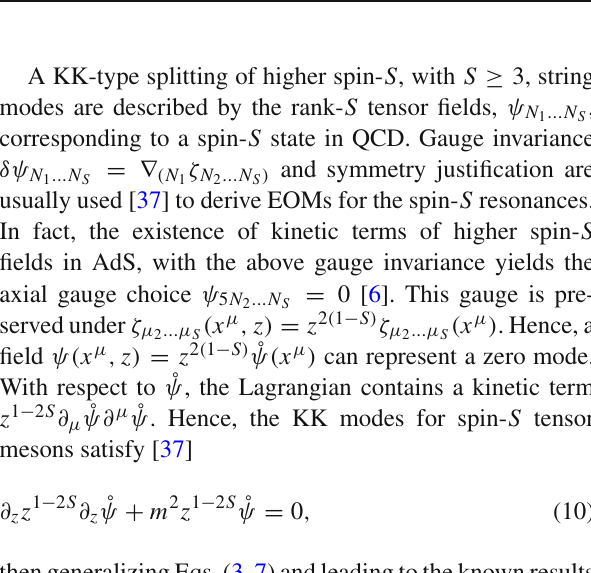
then generalizing Eqs. (3, 7) and leading to the known results for spin-1 and spin-2 modes. The normalizable solutions of Eq. (10) are of the form z S J S ( mz ) .WhenNeumannboundaryconditionsareimposed in the IR regime, Ref. [37] derives the mass of the lightest spin- S particle resonance as the first zero of the J S − 1 ( mz ) function. This leads to the tensor mesons spin- S resonances in QCD. The first column in Table 1 encompasses the spin, S , of the respective spin- S tensor meson resonances, whereas the second column depicts the ρ( 770 ) , f 2 ( 1270 ) , ω 3 ( 1670 ) , f 4 ( 2050 ) , ρ 5 ( 2350 ) , f 6 ( 2510 ) tensor mesons. The third and forth column indicate, respectively, the tensor mesons family mass spectra in PDG [49] and in AdS/QCD hard wall. The = 4 k 2 ( n + soft-wall in Ref. [6], have the mass spectra m 2 n , S S ) , for k = 0 . 388 GeV, displayed in the fifth column of Table 1. This value of k is optimal in what concerns fixing the ρ( 770 ) mass and is most usually employed in the